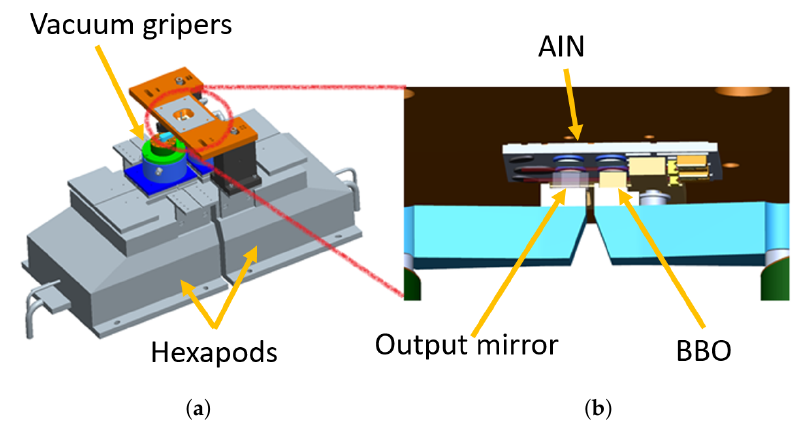
Figure 3. Misalignment study due to alloy shrinkage depending on a semi-sphere base radius (yellow) and KOVAR pad hole diameter (blue) [24]. The soldering alloy SAC305 is ejected onto the semi-sphere and the KOVAR pad though the pad conical aperture.